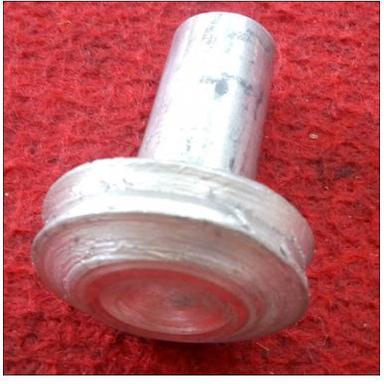
hotograph of mechtrode after friction surfacing